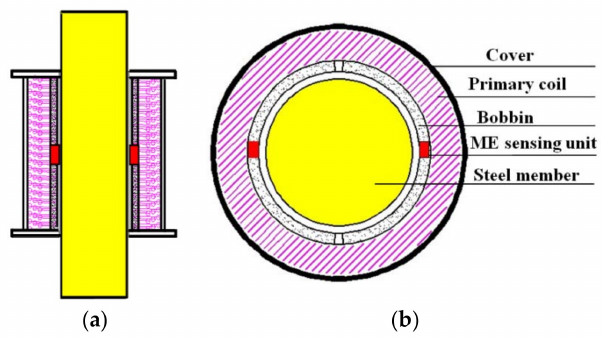
Figure 2. Structure of an EME sensor: ( a ) vertical section view; ( b ) cross-section